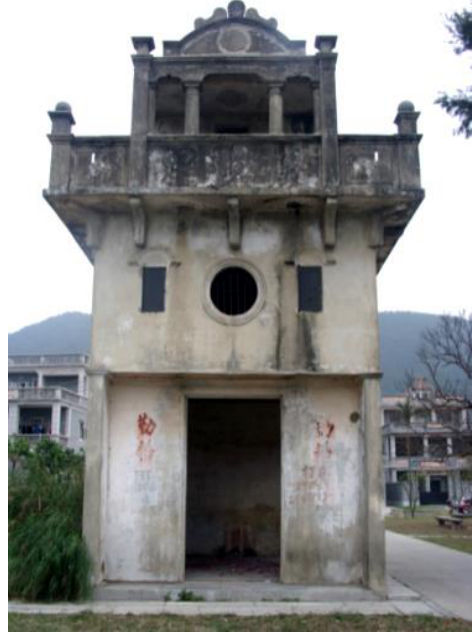
Figure 14. Grotesque form (source: the authors).